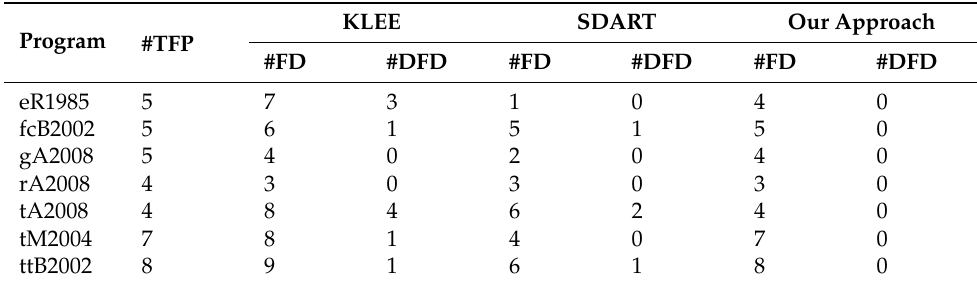
Table 3. Results of detected feasible paths and duplicated paths.